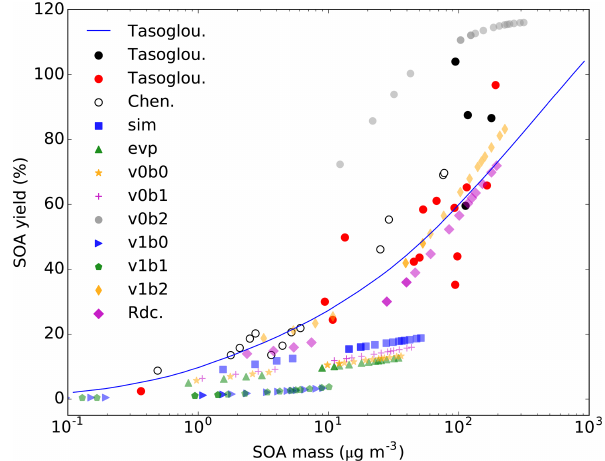
Figure A1. The SOA yields versus the total SOA mass from the experimental data reported by Chen et al. (2012) and Tasoglou and Pandis (2015), simulated in SSH-aerosol with the MCM mechanism and different saturation vapor pressures methods (see the figure leg- end) and simulated with the Rdc. mechanism (purple diamonds). The Rdc. mechanism is trained from the MCM mechanism with the v1b2